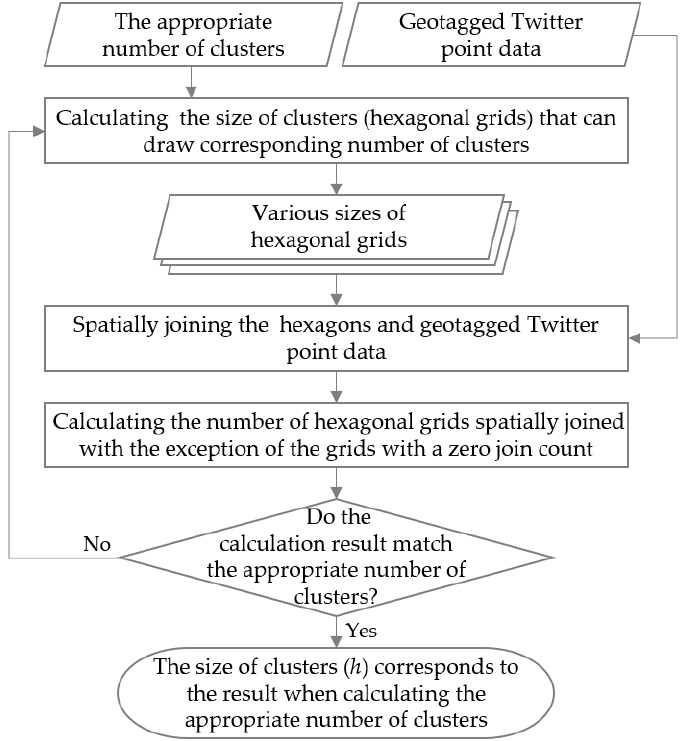
Figure 3. Detailed process of determining the appropriate size of clusters.